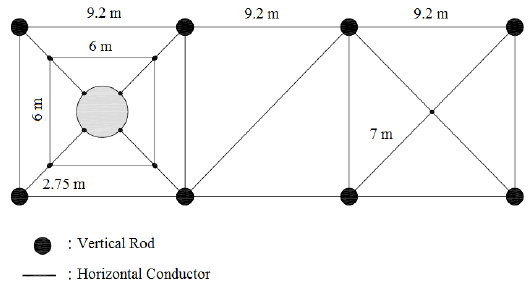
Figure 1. Proposed Modified Grounding Scheme